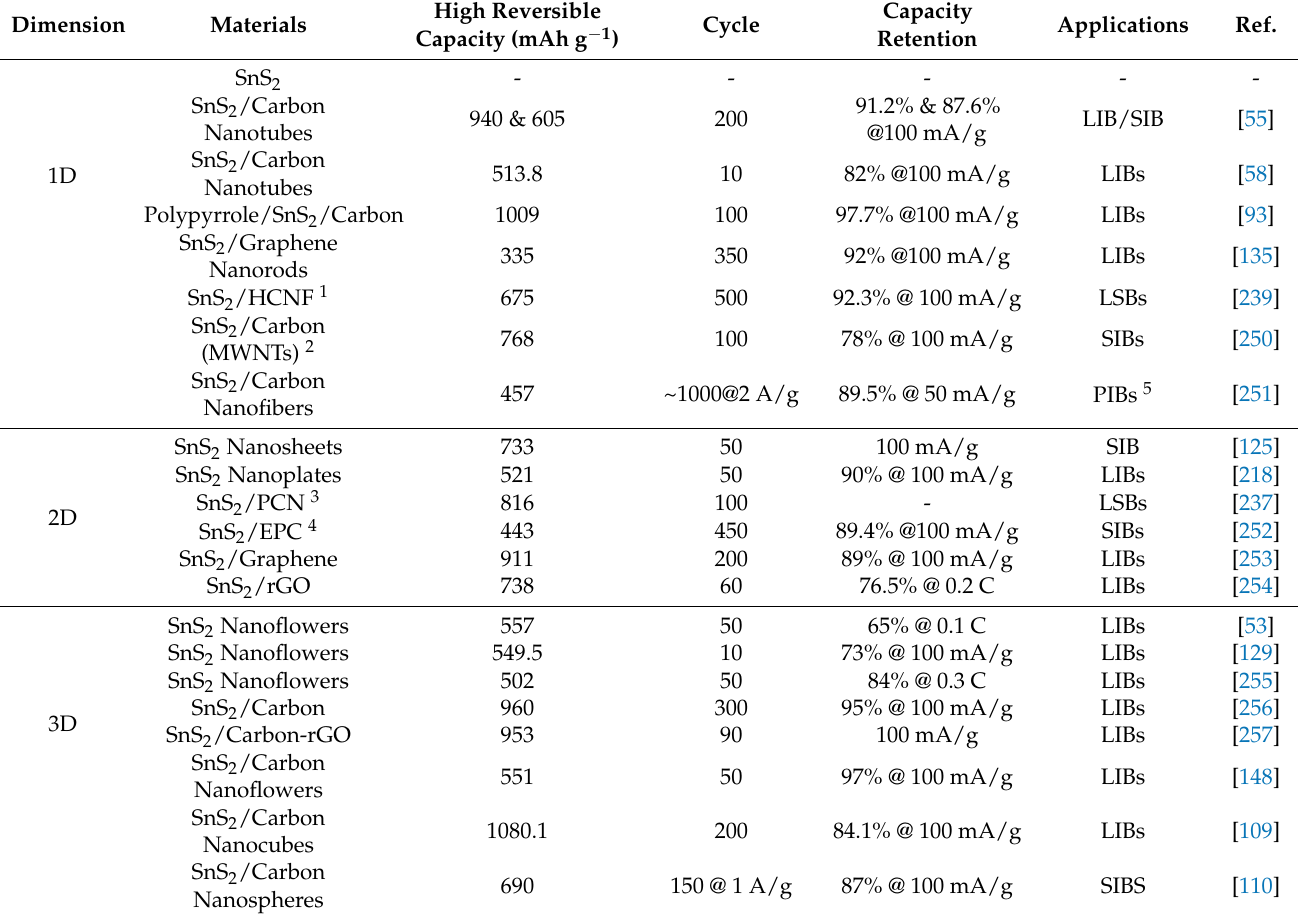
Table 4. Comparison of battery performances of SnS 2 and SnS 2 /Carbon composite